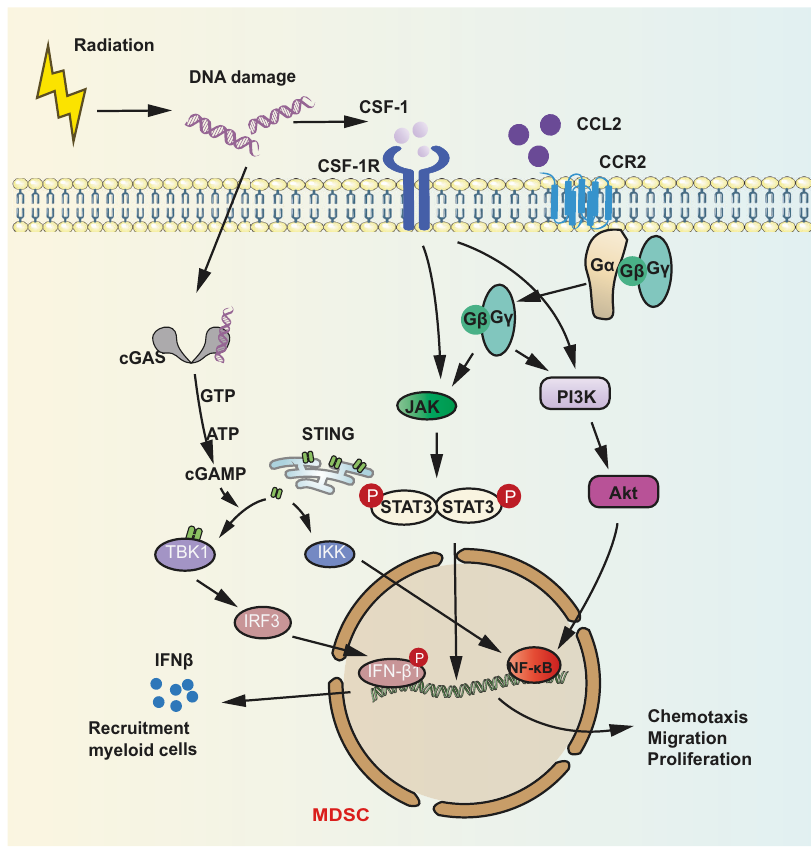
Fig. 6 Immunomodulatory effect of radiation on MDSCs. DNA damage resulted from radiation may activate two signaling pathways in MDSCs: cGAS-STING and JAK/STAT signaling pathways. Similar to signaling pathways in TAMs, JAK/STAT signaling and PI3K/AKT signaling pathway are activated in MDSCs caused by CSF-1/CSF-1R and CCL2/CCR2. Upon DNA damage, all of these damaged DNA including cytoplasmic DNA and mtDNA induced by IR can be recognized by cGAS, which then oligomerizes with DNA in the form of a 2:2 complex. 114 – 116 After binding to DNA, cGAS then exerts a catalytic role to promote the synthesis of the second messenger 2 ′ 3 ′ -cyclic GMP – AMP (cGAMP). Binding of 2 ′ 3 ′ -cGAMP stimulates STING and promotes the translocation to the Golgi which acivates TANK-binding kinase 1 (TBK1). TBK1 phosphorylates STING and promote the interferon regulatory factor 3 (IRF3) to translocate to the nucleus which triggers the expression of IFN- β gene. Parts of this fi gure were drawn with aid of Servier Medical Art (http://www.servier.com), licensed under a